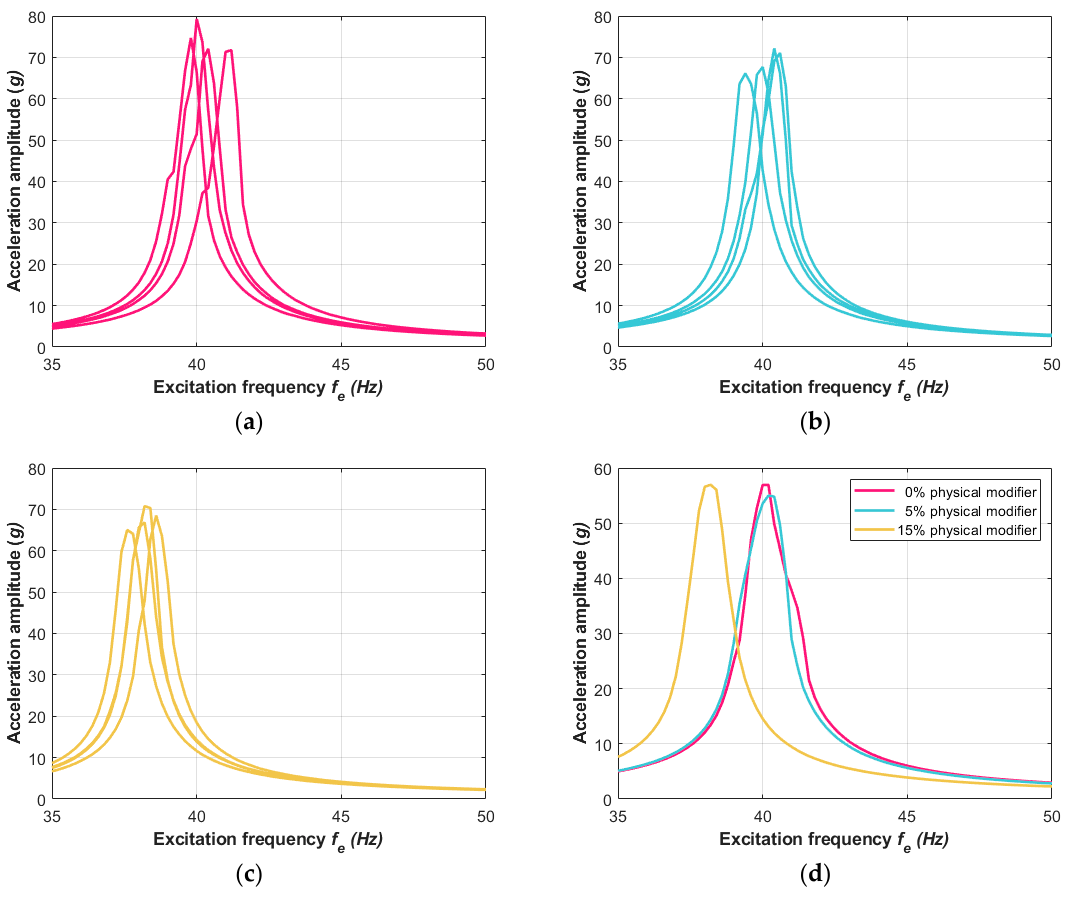
Figure 8. The response acceleration amplitude of the composite beams via excitation with ( a ) 0%, ( b ) 5%, and ( c ) 15% physical modifiers. ( d ) The mean values of the selected characteristics for each case of physical modifier are also included.